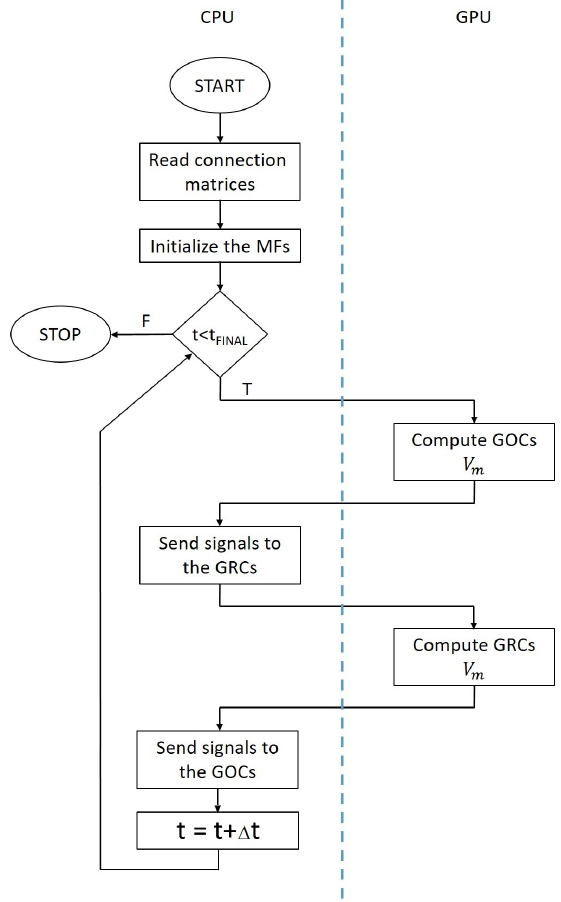
Figure 5. The flowchart of the GPU-based network